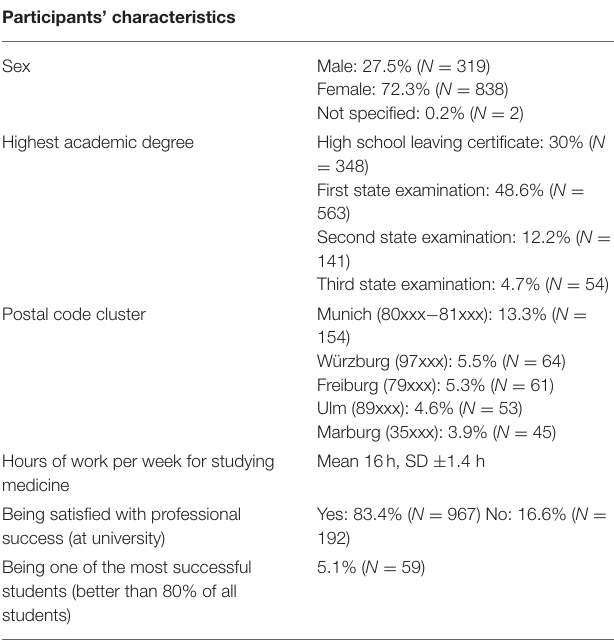
TABLE 1 | Overview of participants’